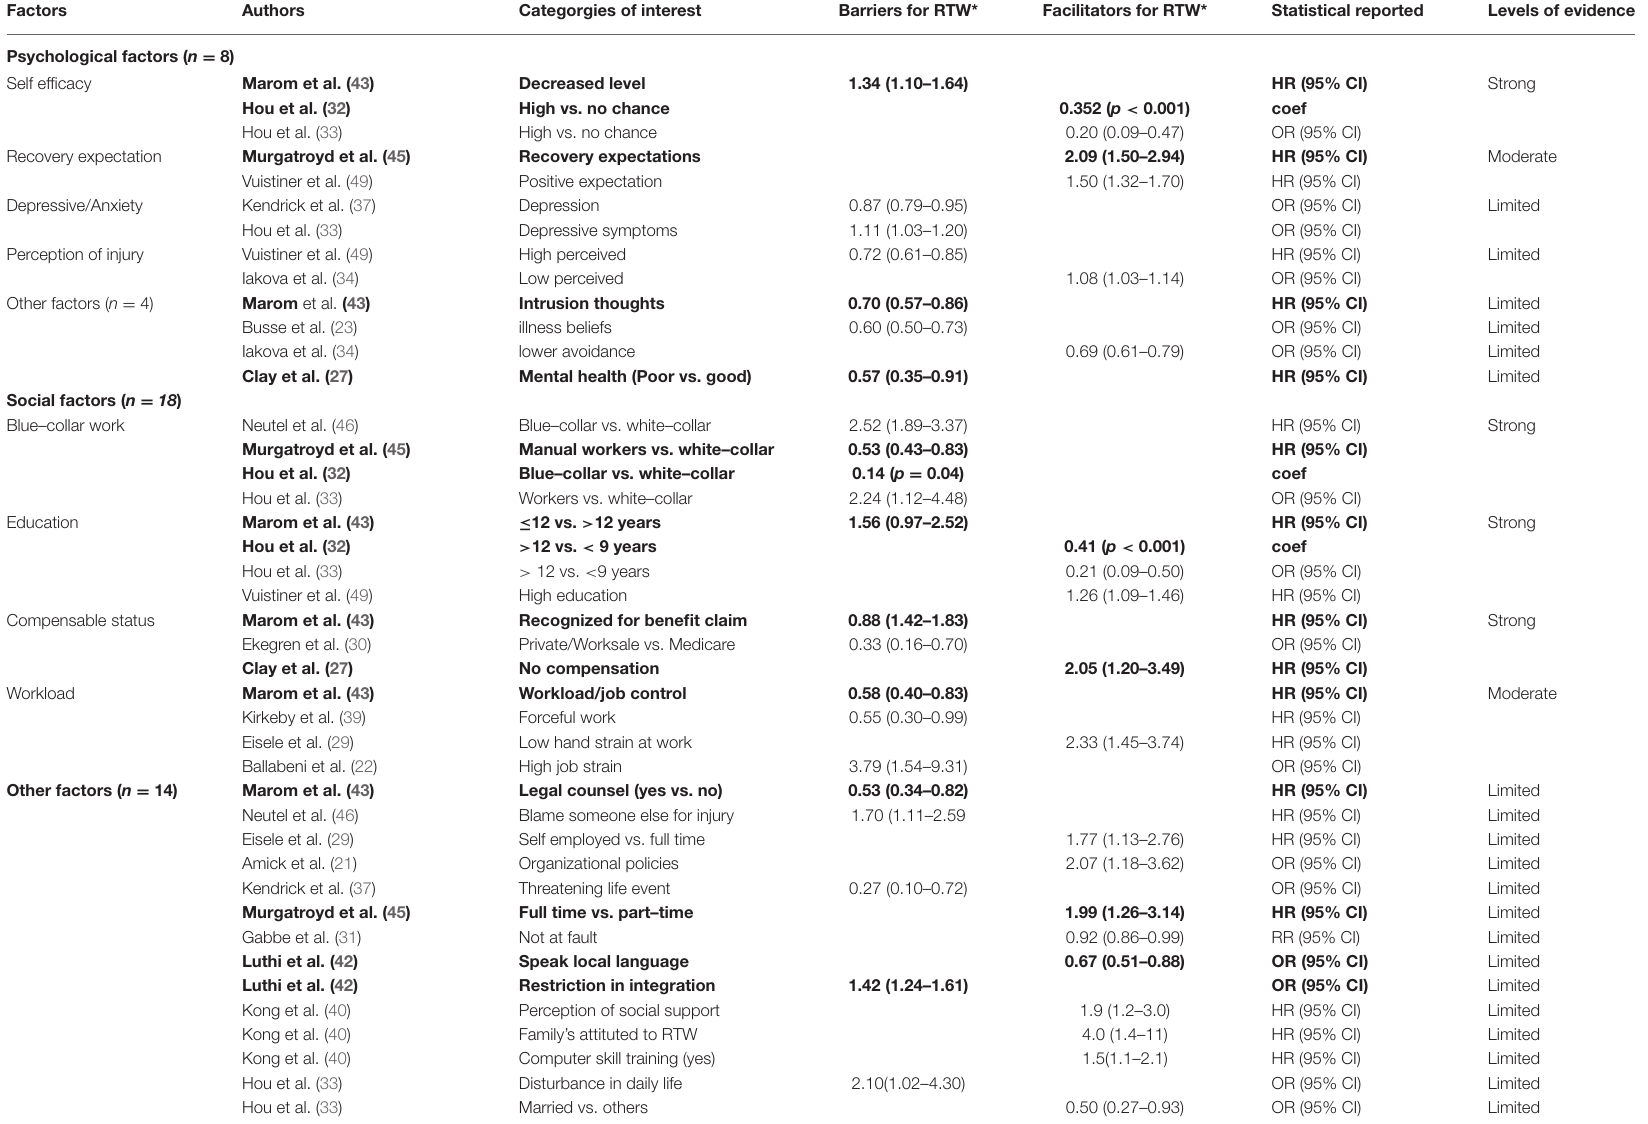
TABLE 4B | Barriers and facilitators for RTW in the late phase ( > 6 months) postinjury (part